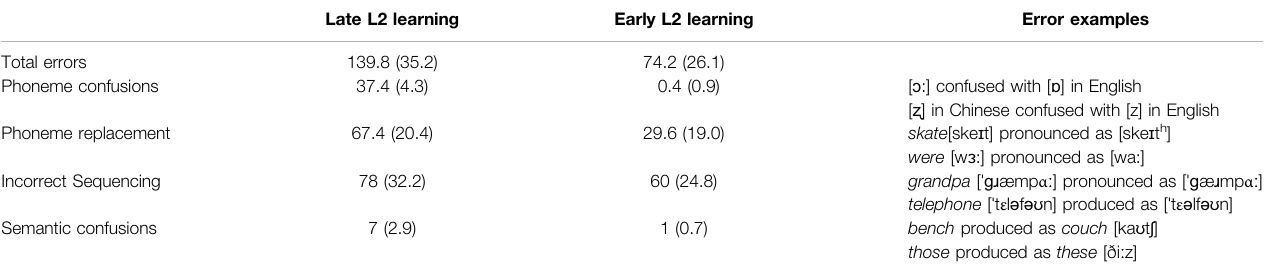
TABLE3| NumberofeachtypeofproductionerrorsinL2(English).Resultsaveragedover5simulationsforeachlearningcondition.Standarddeviationsarelistedwithinthe